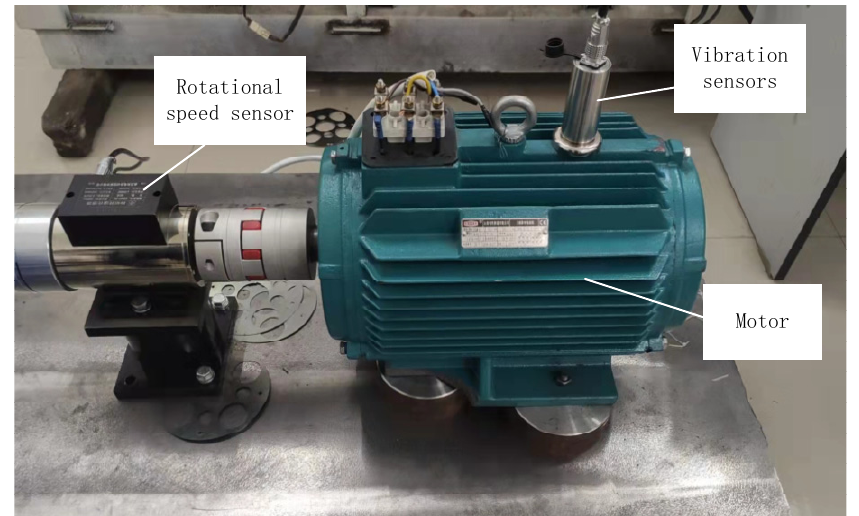
Figure 9. Failure diagnosis experiment platform.